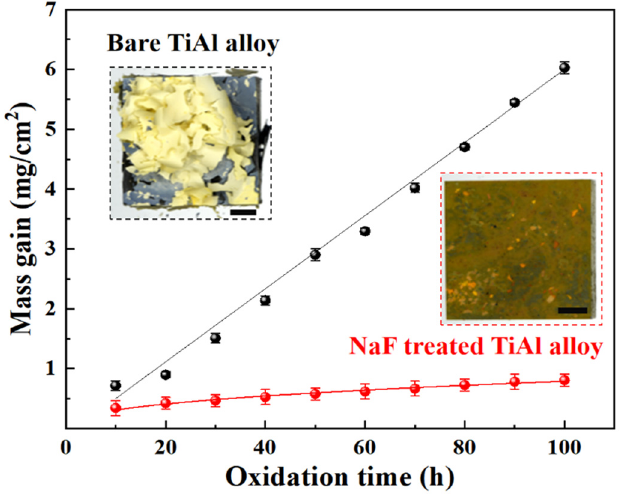
Figure 4. The mass gain curves of Ti-45Al-8.5Nb alloy specimens with and without fluorine treatment during isothermal oxidation at 1000 °C.